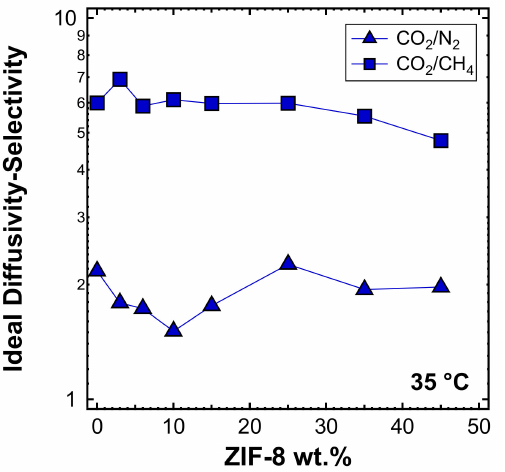
Figure 17. Ideal di ff usivity-selectivity for CO 2 / N 2 and CO 2 / CH 4 at 35 ◦ C in ZIF-8 / PPO